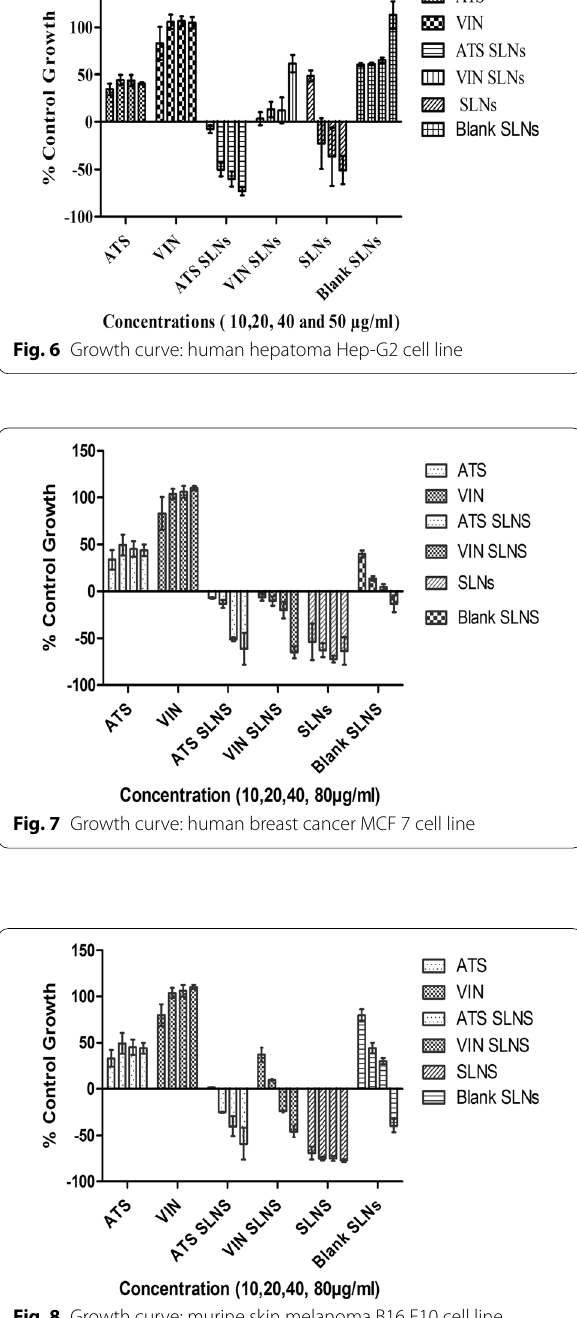
Table 7 IC 50 values of Hepatoma Hep-G2, MCF-7 and melanoma B16 F10 cancer cell line